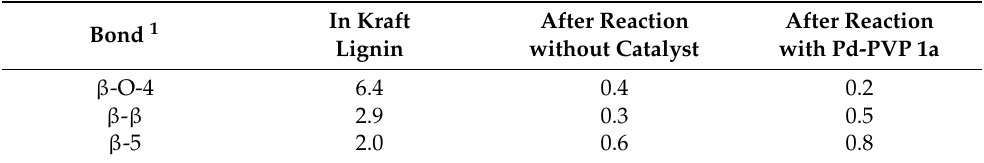
Table 3. Semi-quantitative analysis of initial Kraft lignin and acid-insoluble phase by HSQC